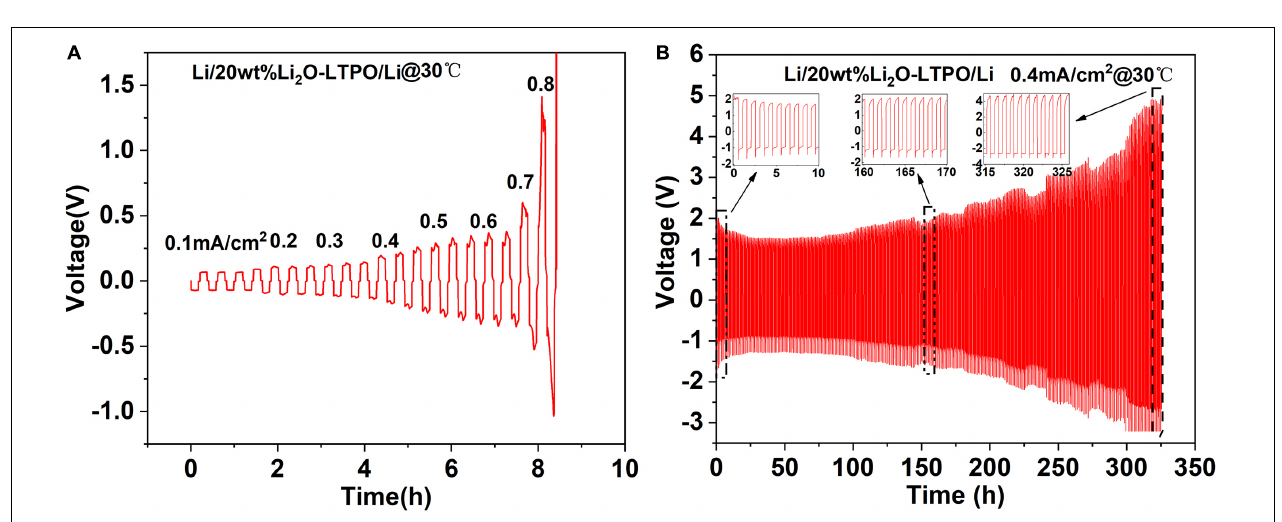
FIGURE 5 | (A) Galvanostatic cycling performance of the Li| LTPO| Li symmetric cell at different current densities (B) 0.4 mA/cm 2 cycle stability of the ceramic electrolyte specimen.